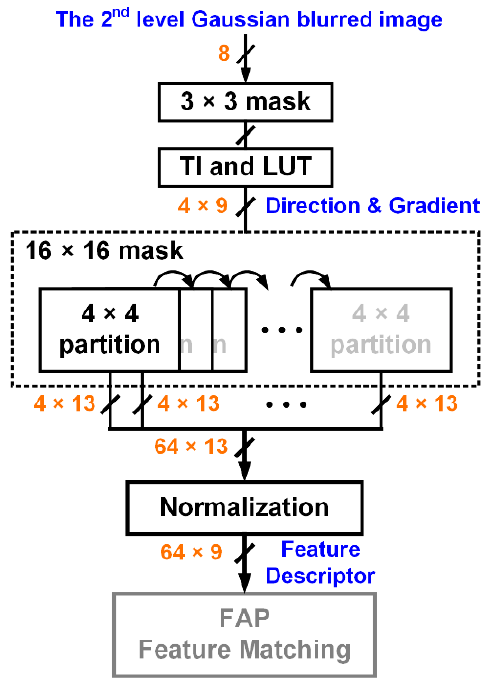
Figure 4. Function blocks of the feature descriptor.